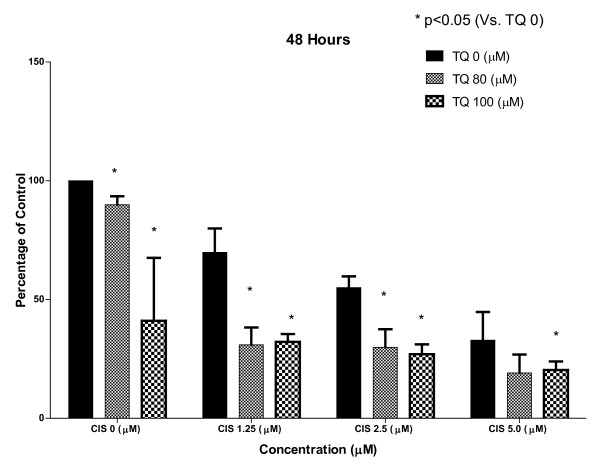
The figure shows results of MTT assay for cell proliferation using NSCLC cell line NCI-H460 at 24, 48 and 72 hrs with control group representing 100% cell proliferation depicted by extreme left solid line. TQ alone is more active at 24 hrs and CDDP more active at 48 and 72 hrs. The combination of TQ and CDDP is more active than each agent alone with up to 89% inhibition of cell proliferation at 72 hrs with combination of TQ 100 μM and CDDP 5 μM. (*) shows significant inhibition by TQ at each level of CDDP (p < 0.05).